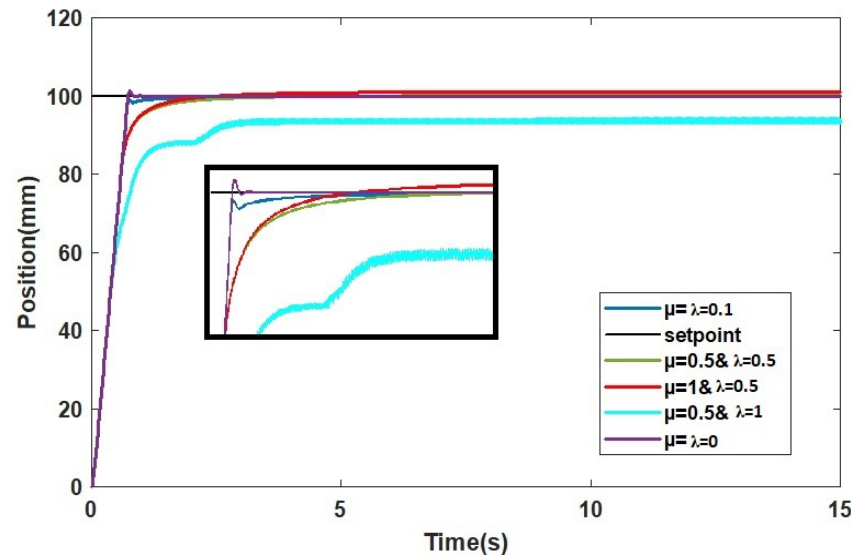
Figure 14. Step response of the system with different values of µ and λ .